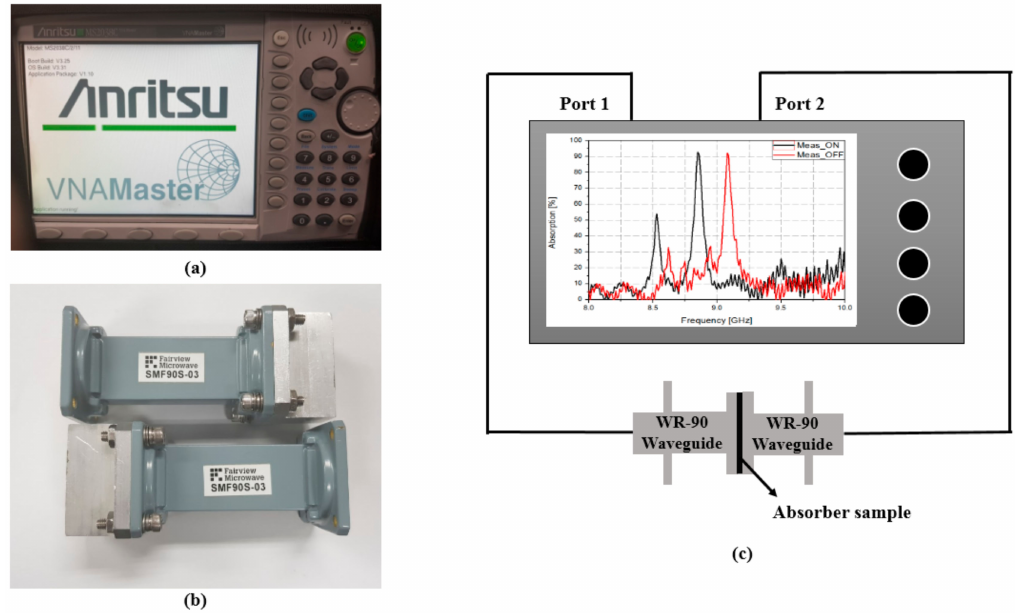
Figure 8. Measurement setup to verify the experiment ( a ) ANRITSU MS2038C Vector Network Analyzer ( b ) WR-90 X-band waveguide ( c ) waveguide measurement setup.